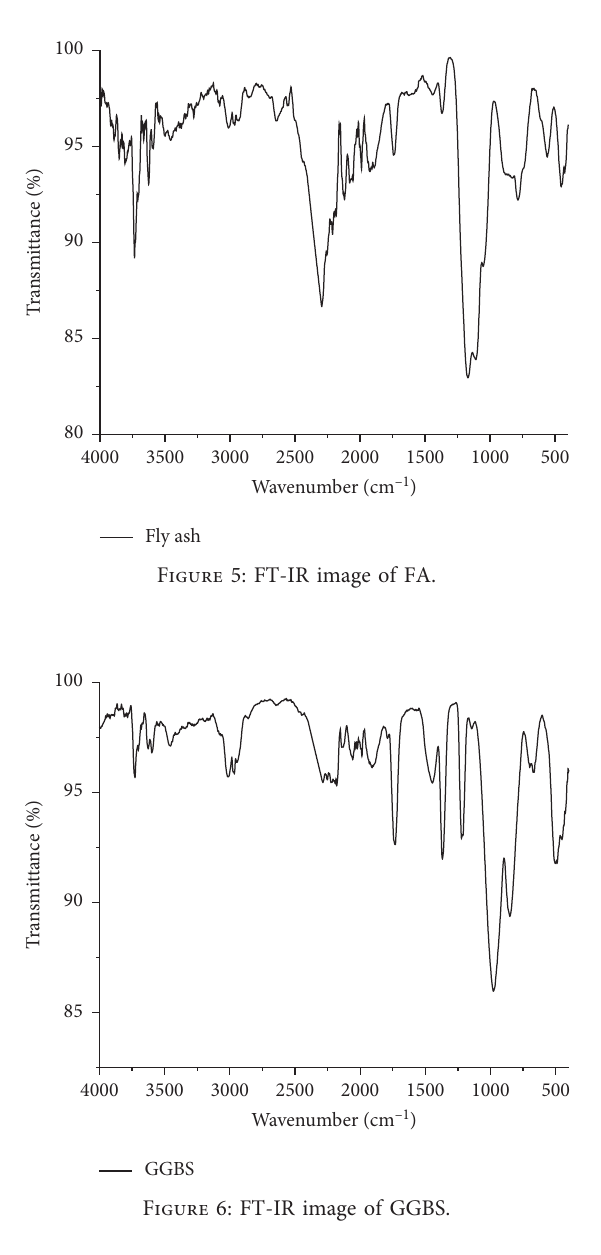
Figure 6: FT-IR image of GGBS.